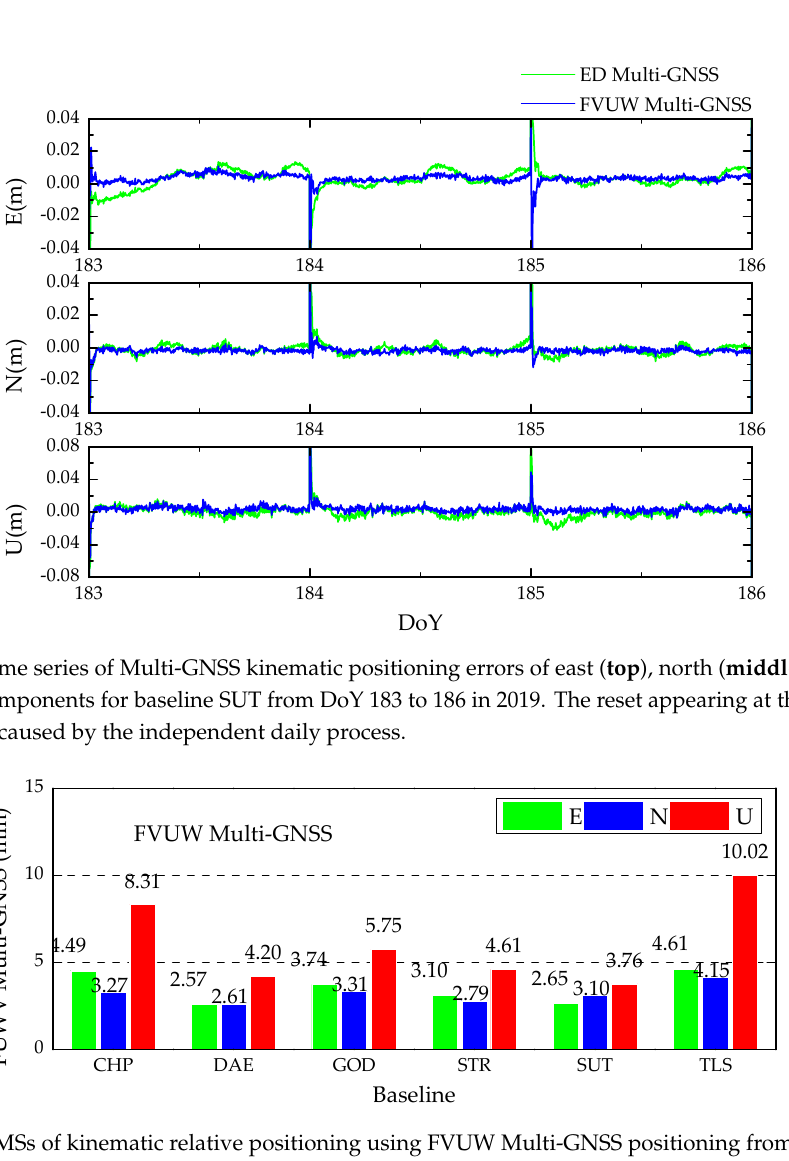
Figure 9. RMSs of kinematic relative positioning using FVUW Multi-GNSS positioning from DoY 171 to 200 in 2019. Table 8. Accuracy improvement percentages of FVUW method compared with ED prior weighting strategy in Multi-GNSS positioning from DoY 171 to 200 in 2019.